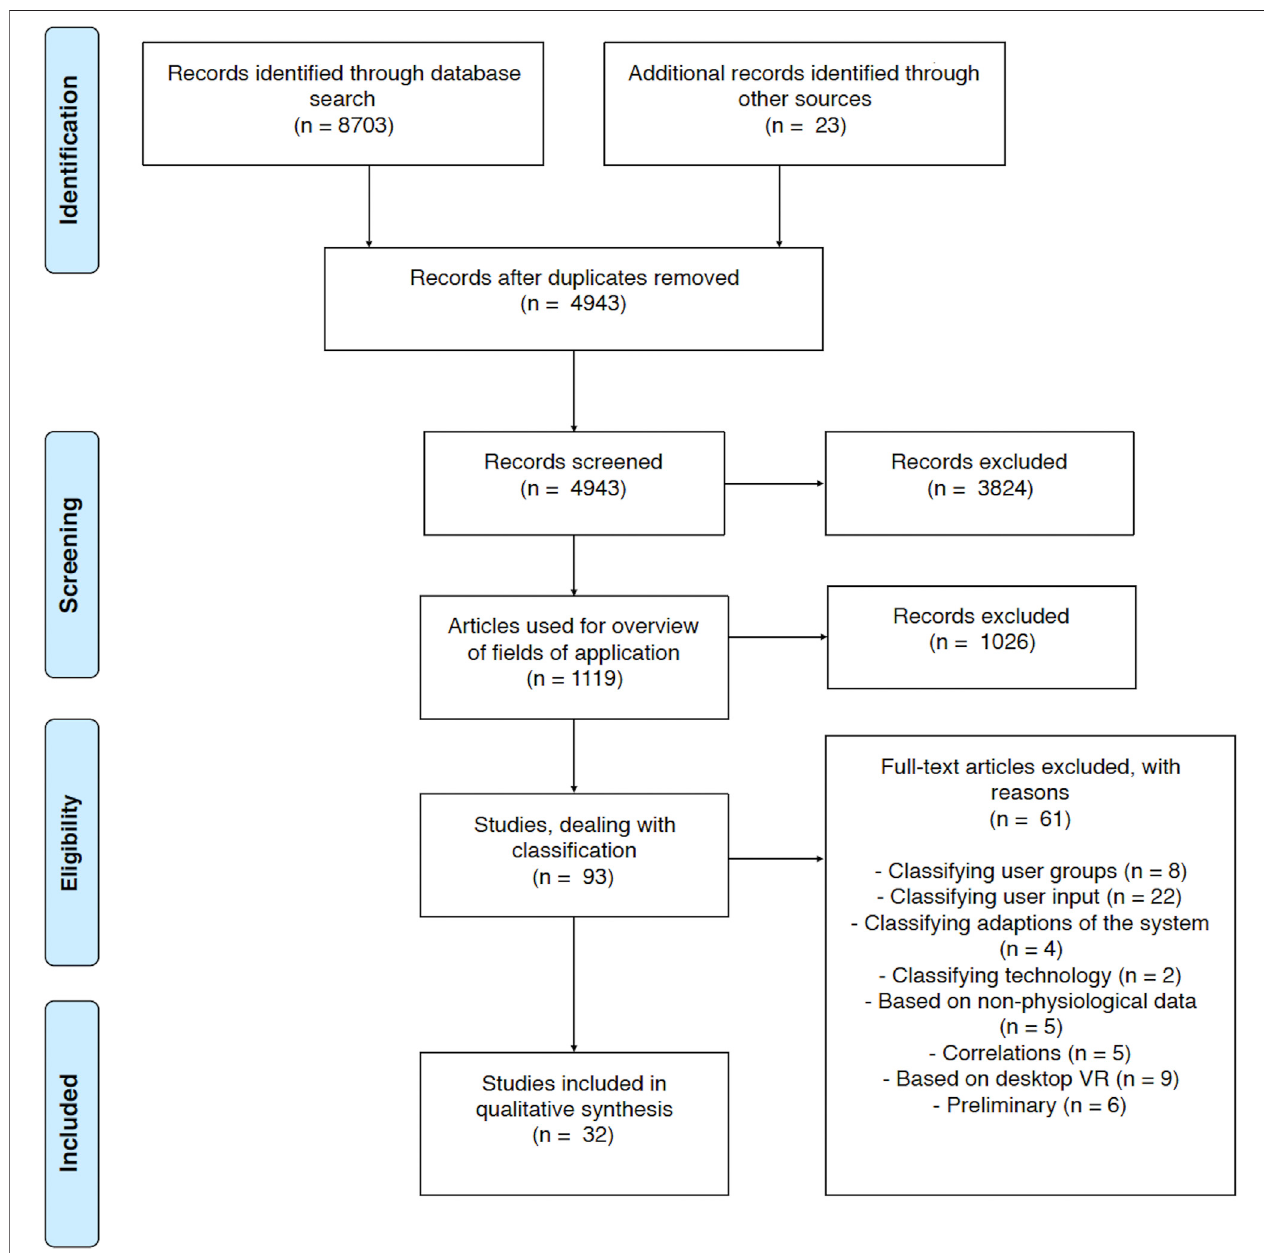
FIGURE 2 | Process and Results of the Literature Review. Diagram is adapted from Liberati et al. (2009).